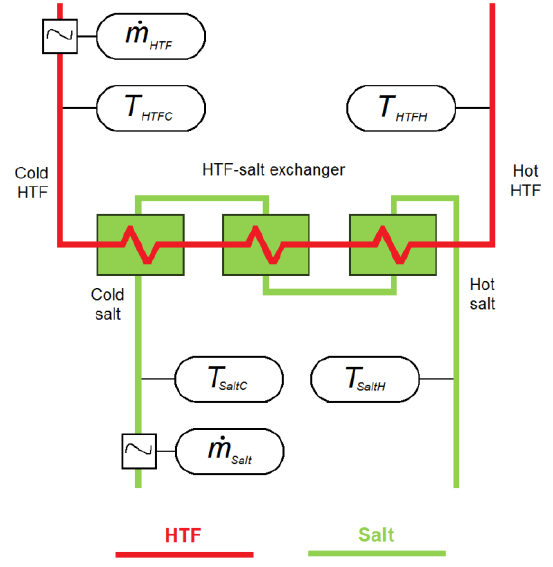
Figure 2. Schematic of the heat